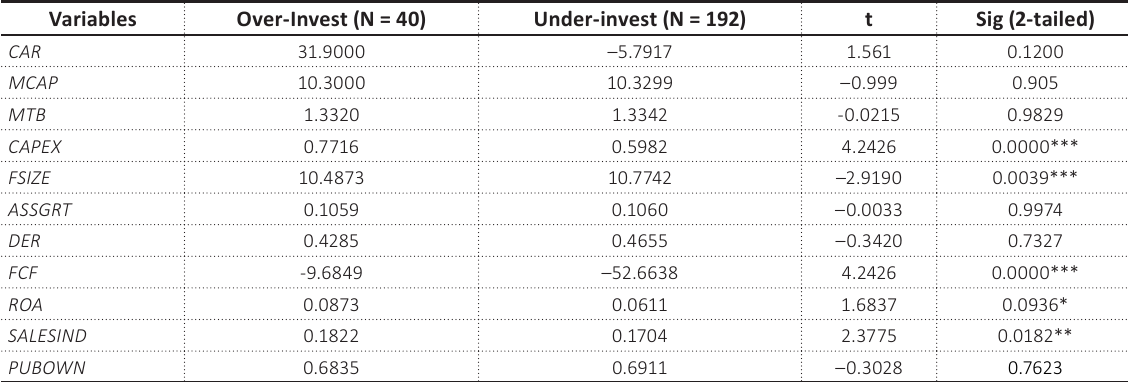
Table 2. Mean-difference between over-invest and under-invest